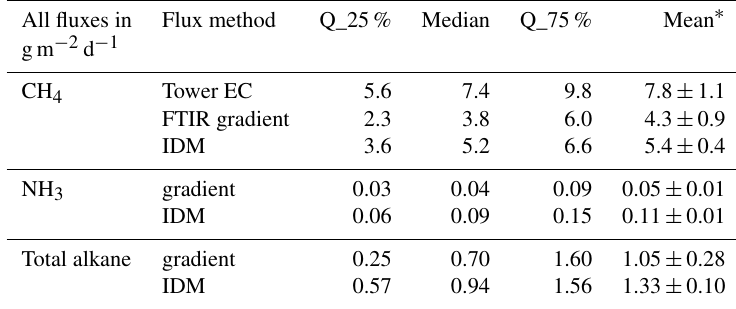
Table 2. Summary of fluxes from OP-FTIR measurements. Results are area-weight-averaged fluxes from the pond. All fluxes in Flux method